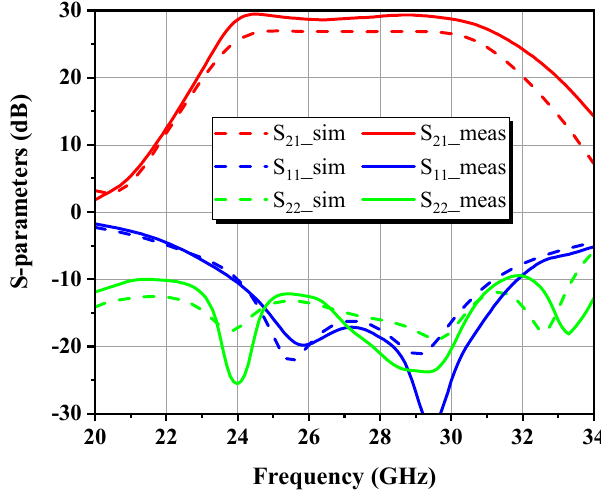
Figure 17. S-parameters of the proposed PA.